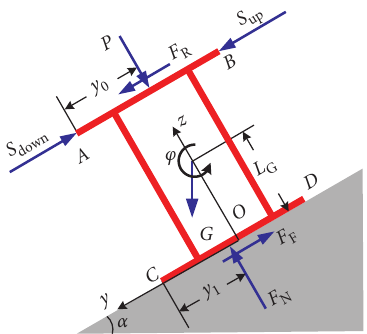
Figure 10: Mechanical model of motion of support along inclined